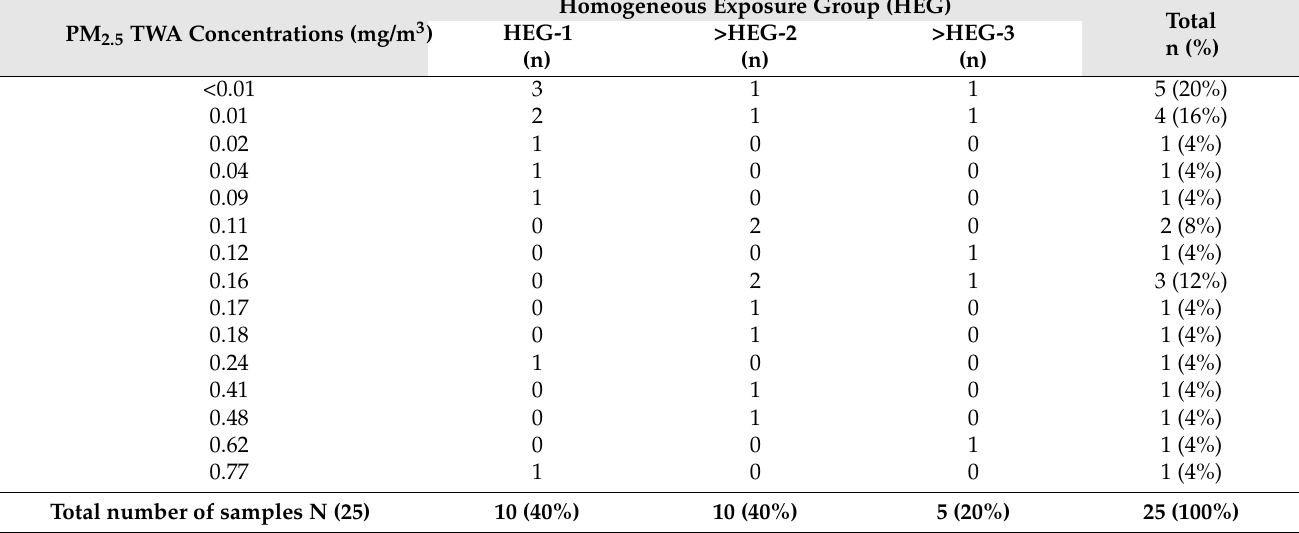
Table 1. Cross-tabulation of personal sampling PM 2.5 concentrations and homogeneous exposure groups (HEG).